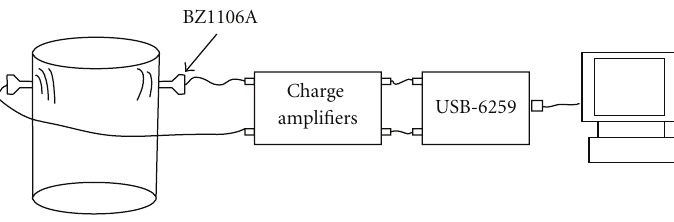
Figure 2: The self-developed signal collection system.